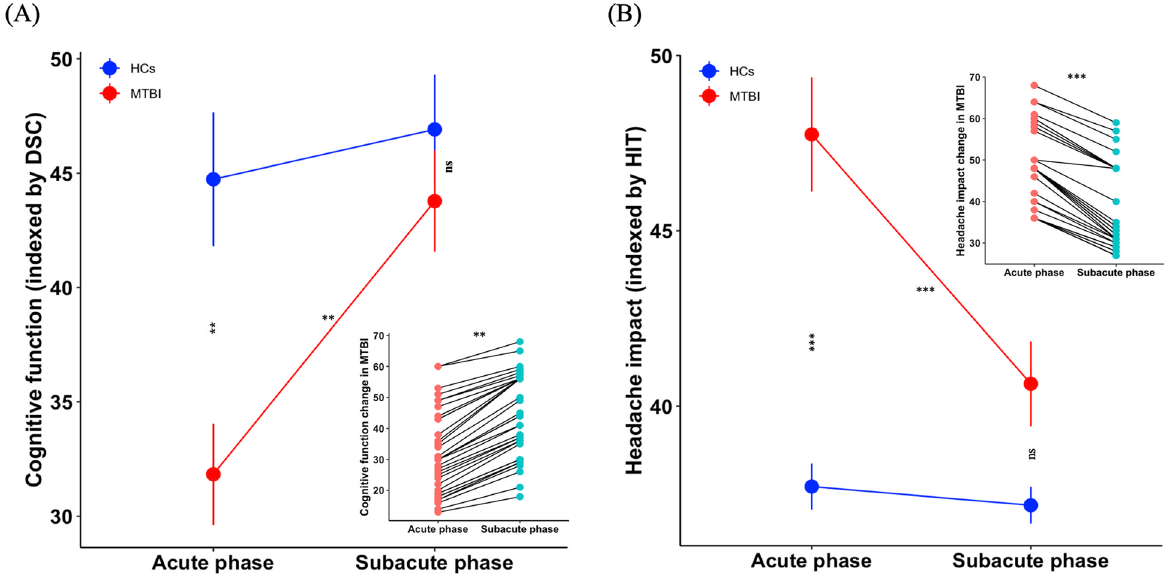
Fig. 2 Clinical symptoms changes in MTBI patients with PTH from acute to subacute phase related to HCs. A Cognitive function (indexed by score of DSC) improvement in patients from acute to subacute phase. The subpanel shows cognitive function change for each patient from acute to subacute phase, which indicates significant cognitive function improvement from acute to subacute phase in patients. B Reduced traumatic-induced headache impact (indexed by score of HIT) in patients from acute to subacute phase. The subpanel shows headache impact change for each patient from acute to subacute phase, which indicates significant reduced headache impact from acute to subacute phase in patients. MTBI, mild traumatic brain injury; PTH, posttraumatic headache; HCs, healthy controls; DSC, Digit Symbol Coding; HIT, the short-form Headache Impact Test. ** , P < 0.01; *** , P < 0.001; ns, not significant. Data are presented as mean ±